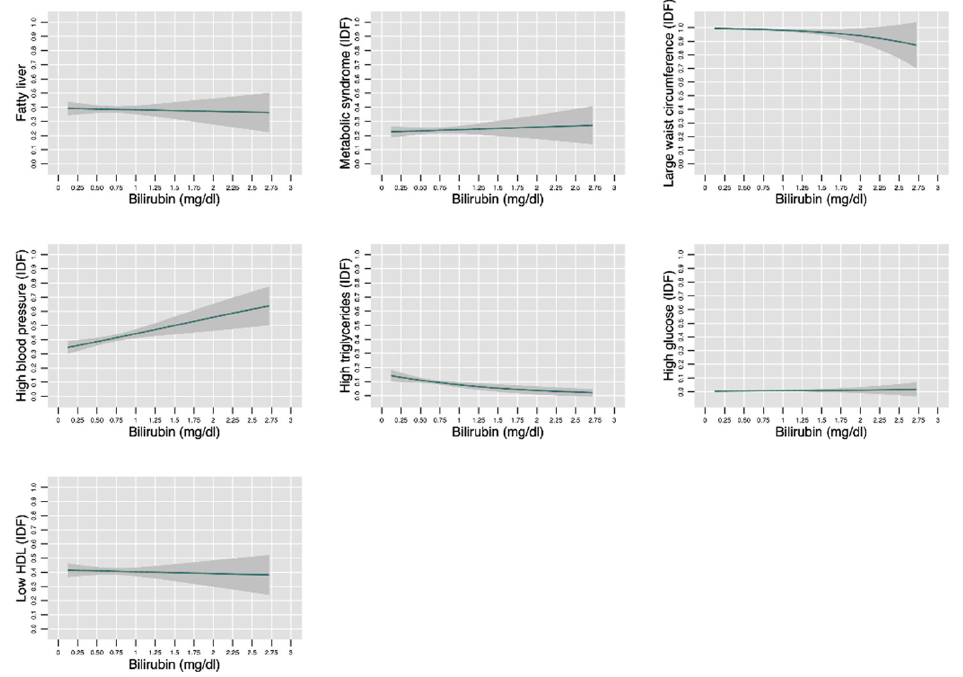
Figure 4. Association between serum total bilirubin, fatty liver, and the metabolic syndrome and its components. See Table 4 for the underlying logistic regression model. Table 4. Univariable logistic regression models evaluating the association between serum total bilirubin, fatty liver, and the metabolic syndrome and its components.